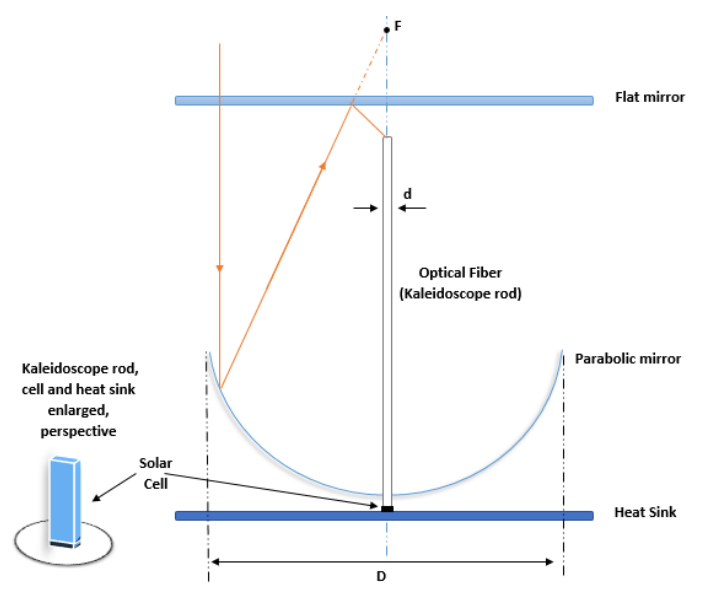
Figure 34. Schematic illustration of a solar mini-dish photovoltaic concentrator